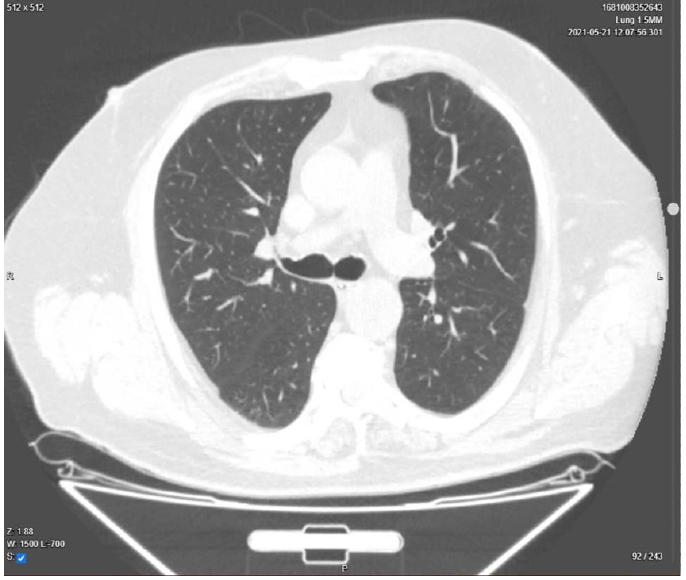
Figure 4. Chest CT. Complete resolution of the pulmonary damage. Day 90 from